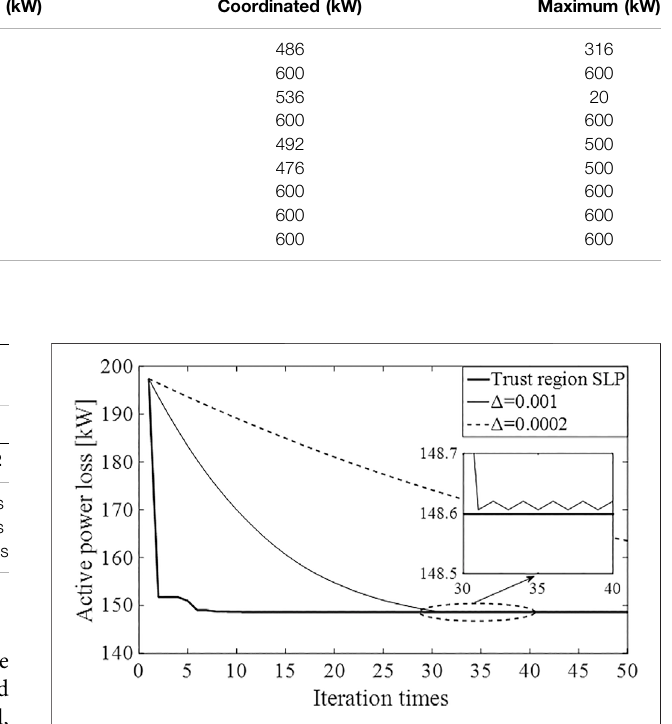
FIGURE 5 | Active power loss variation in scenario